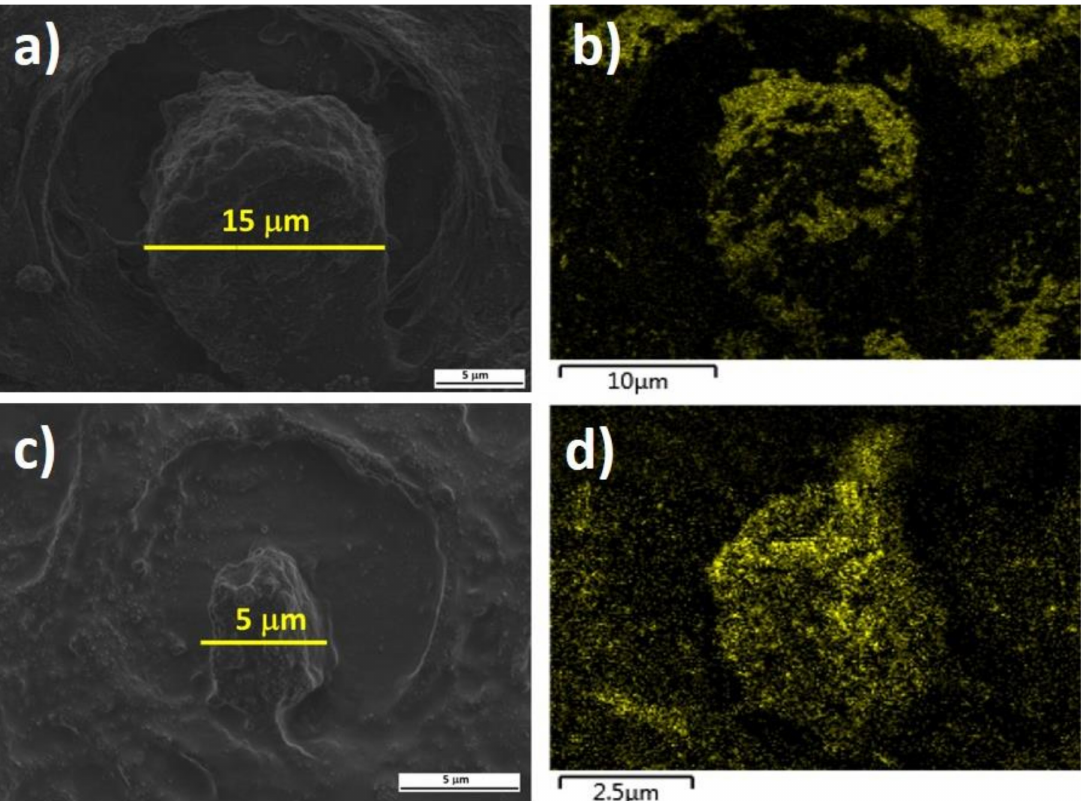
Figure 2. SEM and EDS micrographs of cancerous and HPV-infected tissues impregnated with Au NPs ( a ) SEM of carcinogenic cell; ( b ) EDS map of gold (shown in green) in the same region as panel ( a ); ( c ) SEM of HPV-infected cell; ( d ) EDS map of gold in the same region as panel ( c ). Note the difference in scale bars for each